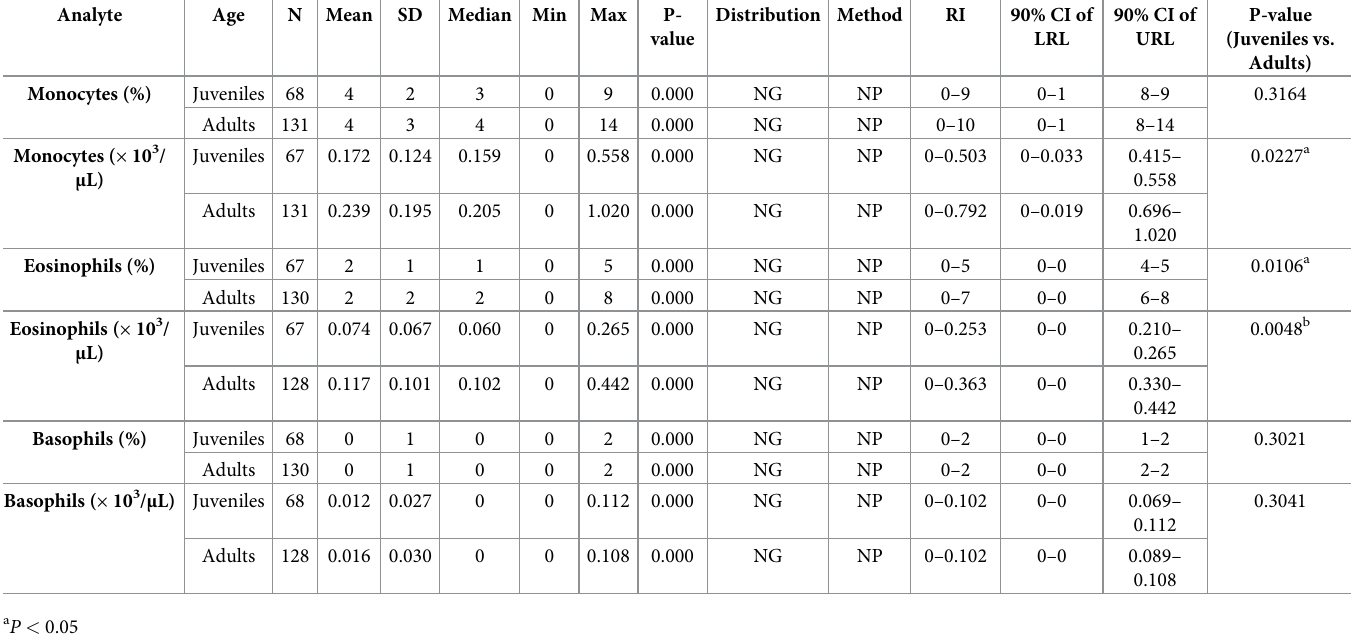
Serum biochemistry Descriptive statistics and reference intervals were established for serum biochemistry analytes of 49 juveniles (41 males; 8 females) and 145 adult (93 males; 52 females) Dunkin Hartley guinea pigs (Table 4). Magnesium was unavailable from 11 adult males. Iron was unavailable from 28 juvenile males and 23 adult males. Additionally, there was insufficient blood volume to complete testing of all analytes in some animals: glucose (2 juveniles; 1 adult), BUN (2 juveniles; 1 adult), creatinine (1 juvenile; 1 adult), phosphorus (2 juveniles), calcium (3 juveniles), magnesium (3 juveniles), total protein (2 juveniles), globulin (2 juveniles), A/G (2 juveniles), cholesterol (1 juvenile; 1 adult), total bilirubin (2 juveniles), ALP (1 juvenile), ALT (1 juvenile), GGT (1 juvenile), bicarbonate (2 juve- niles), anion gap (2 juveniles; 1 adult), and calculated osmolality (2 juveniles; 1 adult). Significant differences in biochemistry parameters between juveniles and adults are shown in Table 4. Glucose (median difference 26 mg/dL; 95% CI 16–44; P < 0.0001), BUN (median difference 3 mg/dL; 95% CI 2–4; P < 0.0001), creatinine (median difference 0.0 mg/dL;